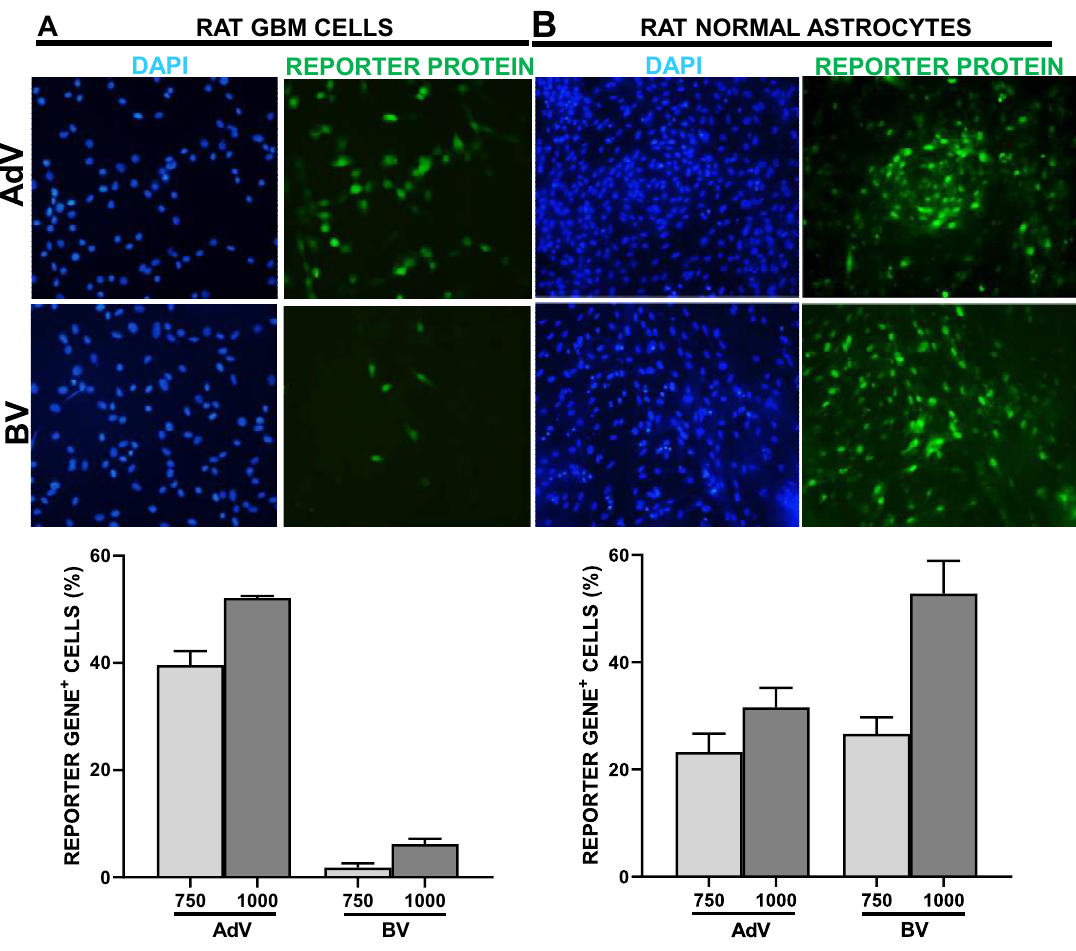
Figure 3. AdV and BV transduction efficiency in rat normal and neoplastic astrocytes in vitro. C6 rat GBM cells ( A ) and primary cultures of normal rat astrocytes from brain cortex ( B ) were incubated with AdV or BV at different MOIs, and 48 h later, transgene expression was assessed by fluorescent microscopy and quantified using ImageJ. Representative microphotographs are shown (MOI = 750). Nuclei were stained with